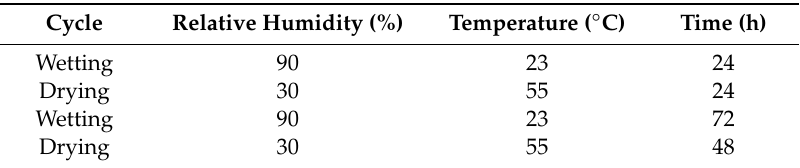
Table 3. Definition of a wetting–drying